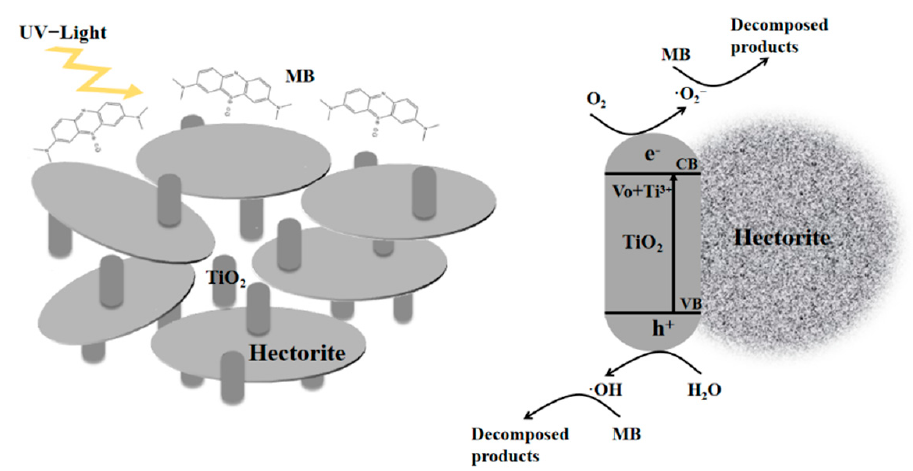
Figure 9. Schematic illustration of a photocatalytic mechanism for the degradation process of MB under UV light toward TH-2 composite.